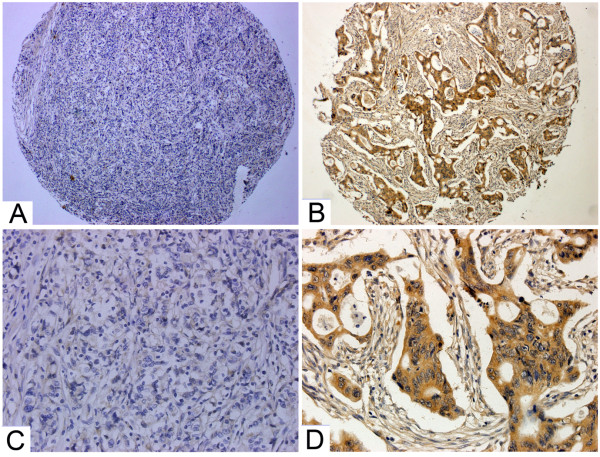
In situ hybridization analysis of miR-199a-5p expression in gastric cancer tissue. (A, C) negative expression of miR-199a-5p in gastric cancer tissue, A: magnification × 100, C: magnification × 400; (B, D) positive expression of miR-199a-5p in gastric cancer tissue, B: magnification × 100, D: magnification × 400.